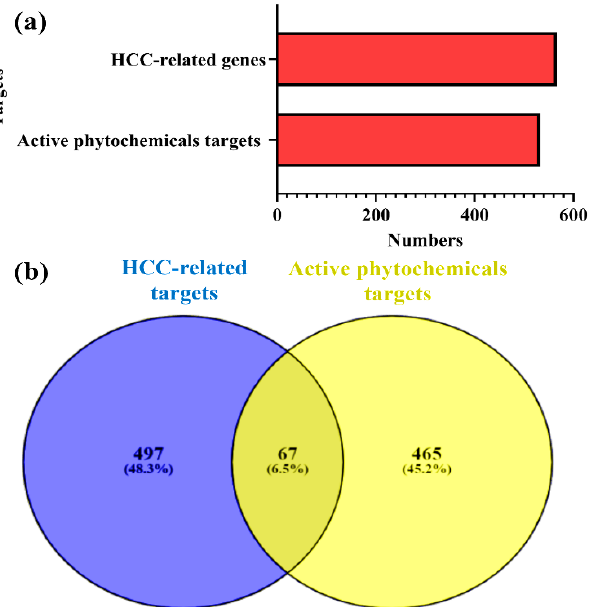
Figure 2. ( a ) Potential protein targets of active phytochemicals in Cnidium monnieri and HCC-related genes. ( b ) Intersecting targets between the active phytochemical potential protein targets in Cnidium monnieri and HCC-related genes determined by VENNY 2.1.